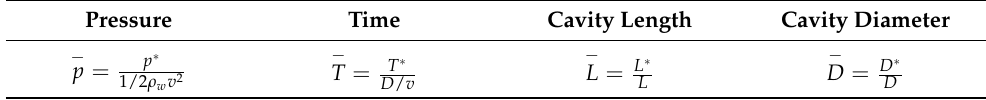
Table 3. Non-dimensionalization of physical